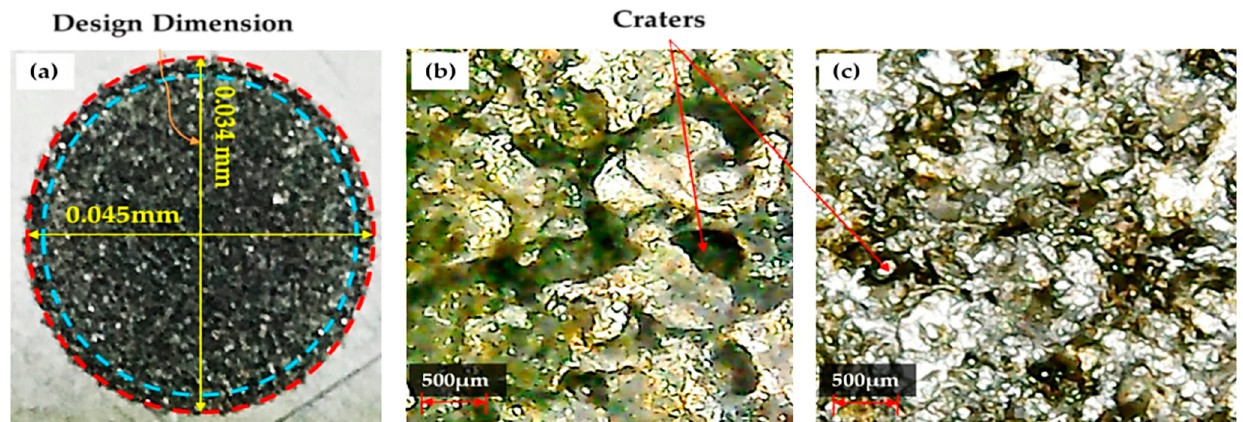
Figure 10. Experimental outcomes for Al-electrode with 3 V spark voltage: ( a ) actual machined surface characterized by R DE = 0.045 mm and A DE = 0.034 mm; ( b ) micrograph showing the smaller number of craters present on workpiece surface; ( c ) micrograph of the electrode surface showing the presence of only one or two craters.